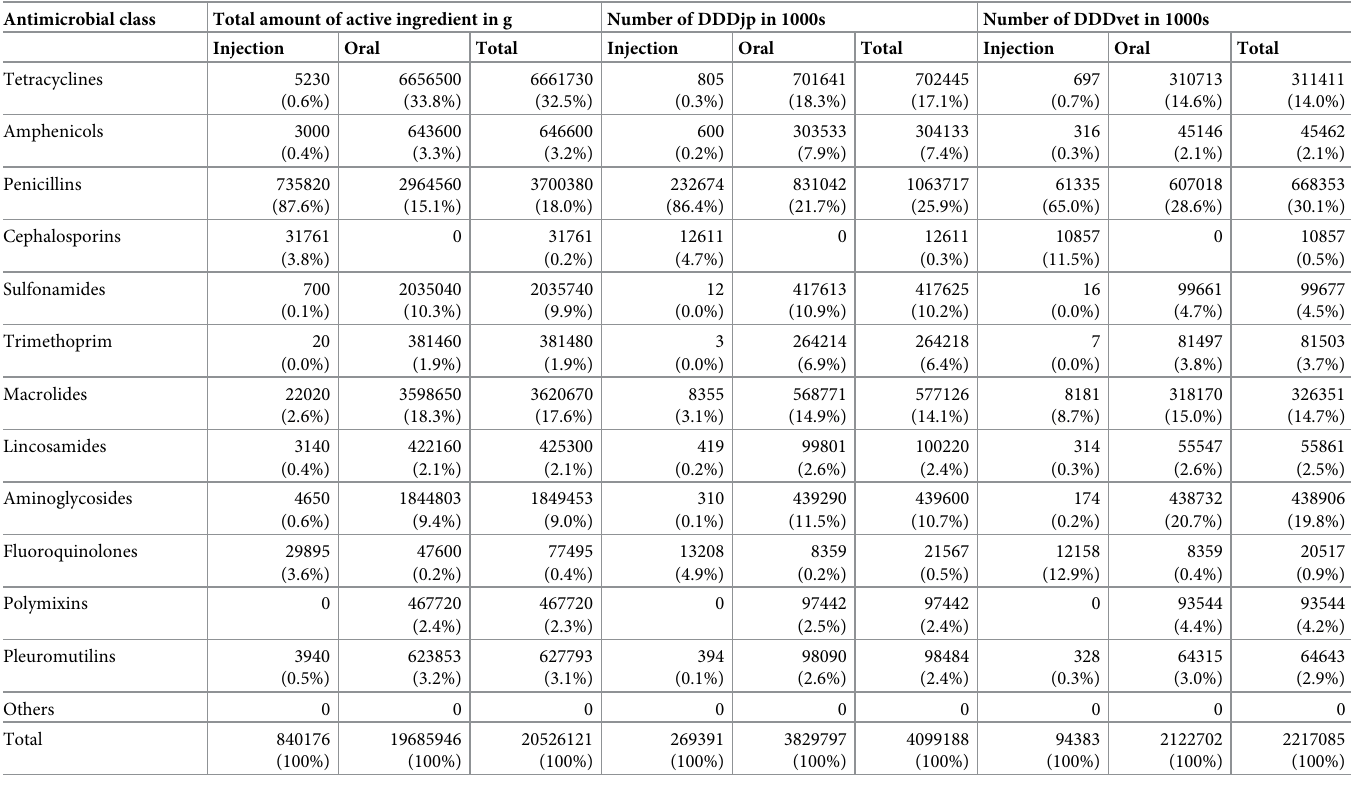
Table 3. Total antimicrobial use on the 74 pig farms measured as active ingredient and by Japanese and European DDD grouped by different antimicrobial classes. Antimicrobial class